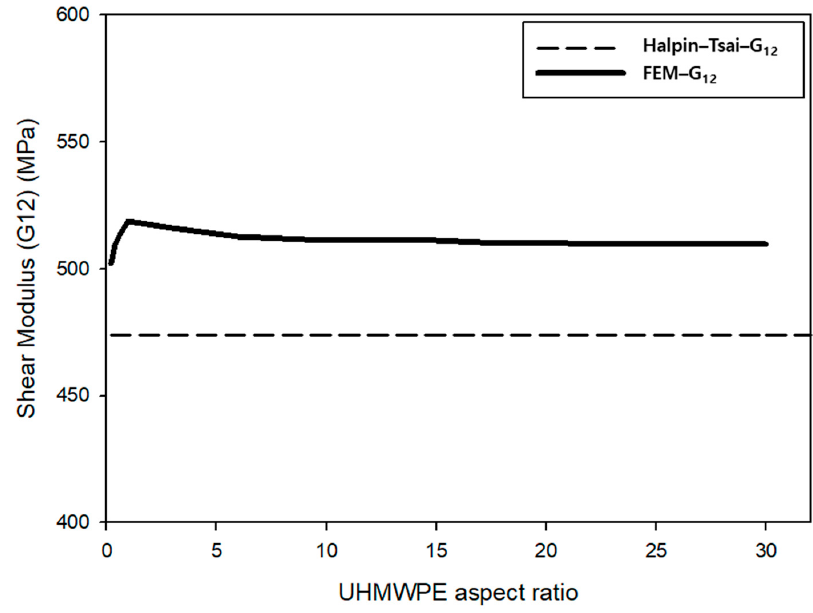
Figure 7. Shear modulus (G 12 ) according to the UHMWPE aspect ratio.